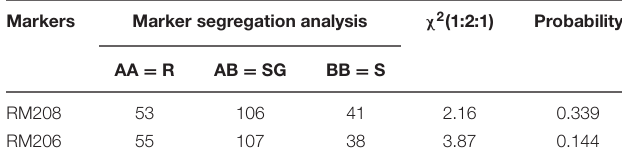
TABLE 1 | Analysis of markers in BC 2 F 2 segregating population.